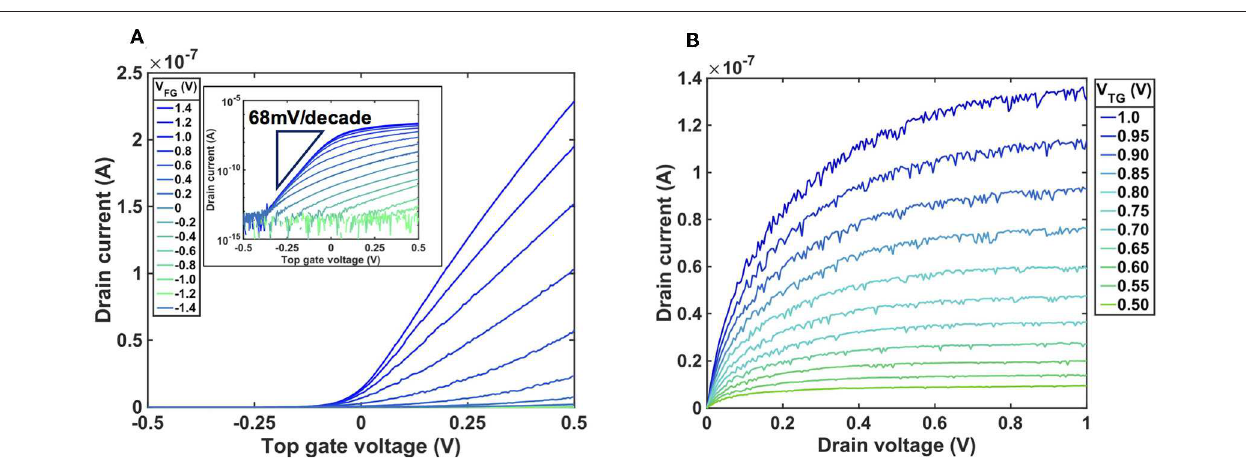
Figure 3I . In Figure 3J , I D,High was plotted against V TG as squares, while I D,Low was plotted against V TG as circles. These two plots ( I D,High vs. V TG and I D,Low vs. V TG ) can be considered as two transfer characteristics with different V th values (low V th and high V th ) in the same device. The difference in V th between the two V th states can be precisely evaluated by finding a fitting function for I D,High [ f ( V TG )] and shift f ( V TG ) by 1 V th . The fitting function f ( V TG ) was determined phenomenologically as a parabolic function with regards to the linear trend of the amplitude of RTS ( 1 I = I D,High – I D,Low ) against V TG ( Figure 3J and its inset). f ( V TG ) was plotted as a dotted line in Figure 3J . f ( V TG − 1 V th ) was plotted with a 1 V th of 24 mV, shown in Figure 3J as a broken line, which reproduced the original data trends with sufficiently small deviations. Here, 1 V th of 24 mV was determined by the least square fitting. Therefore, the high current state can be attributed to the low V th state, while the low current state can be assigned to the high V th state. This indicates that the V th of our transistor was randomly switching between two states, exhibiting itself as RTSs, and as V TG